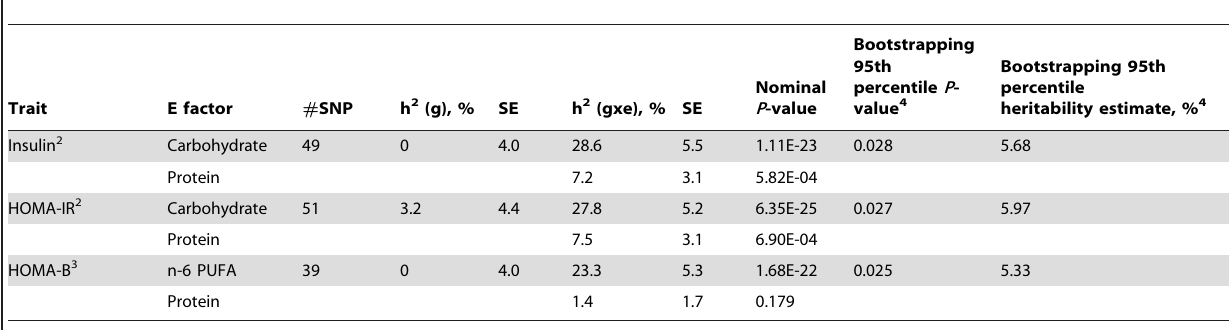
Table 4. Estimation of heritability (%) from identified SNPs with nominal P -value , 1.0E-5 based on GxE GWAS 1 .